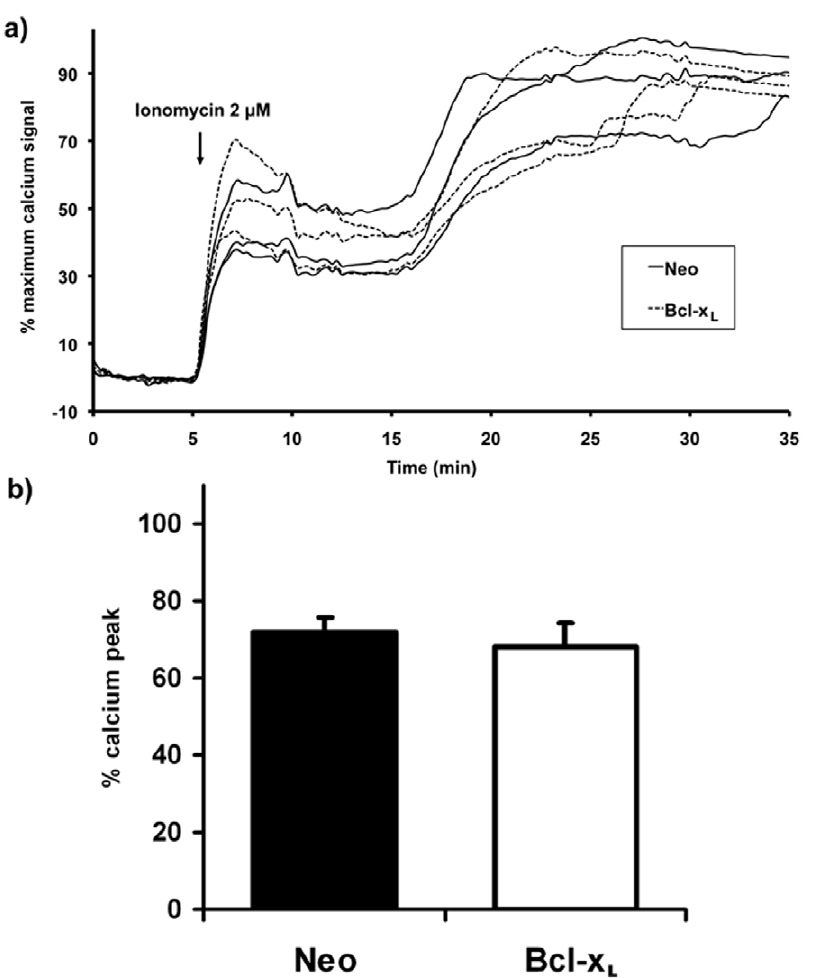
Figure 2. Lack of effect of Bcl-x L over expression on ionomycin-mediated increase in Ca 2 + levels. a) Time-course of Ca 2 + levels, expressed as percentage of maximum Ca 2 + response, following ionomycin (2 m M; arrow) addition to SH-SY5Y/Neo (solid lines) and SH-SY5Y/Bcl-x L cells (dashed lines). Following an initial Ca 2 + peak, a late Ca 2 + increase occurs reaching a plateau that is taken as the maximum Ca 2 + level for the neuron. b) Cytoplasmatic response to ionomycin treatment (2 m M) in SH-SY5Y/Neo (n=10) and SH-SY5Y/Bcl-x L (n=11) cells measured as the ratio of the early Ca 2 + peak to the maximal ionomycin signal obtained during each individual experiment. Data represent mean 6 S.E.M of the indicated number of experiments.